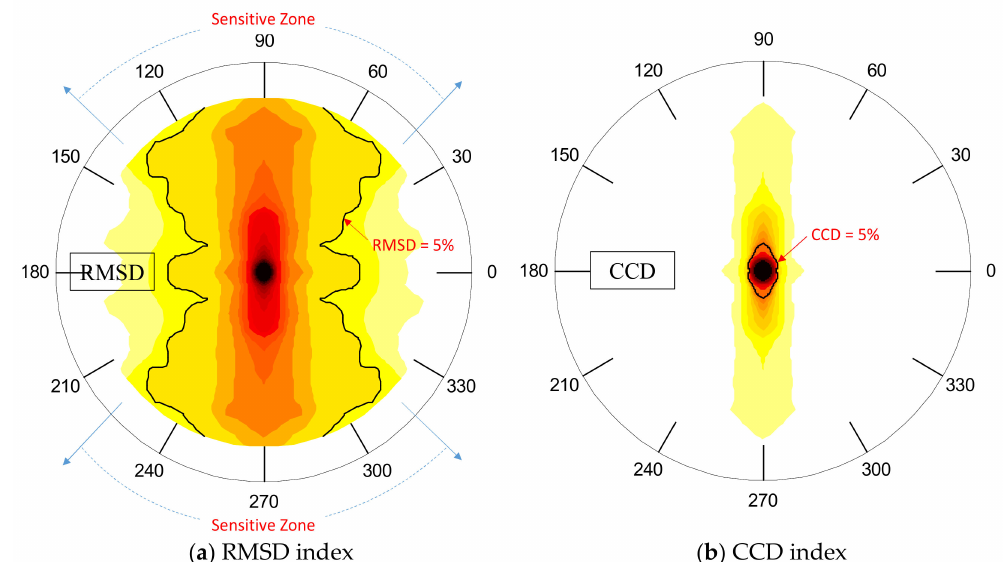
Figure 7. Detectable zone of PZT interface over circular plate domain: Peak 1 in 10–20 kHz.